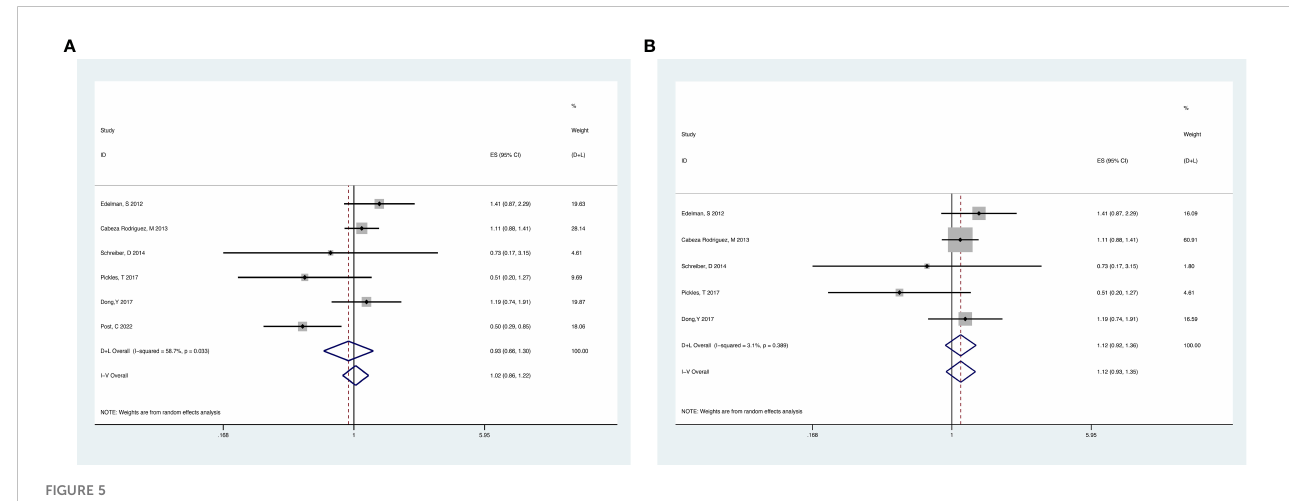
FIGURE 5 Forest plot for OS of 6 retrospective studies before the sensitivity analysis (A) , after the sensitivity analysis (B)